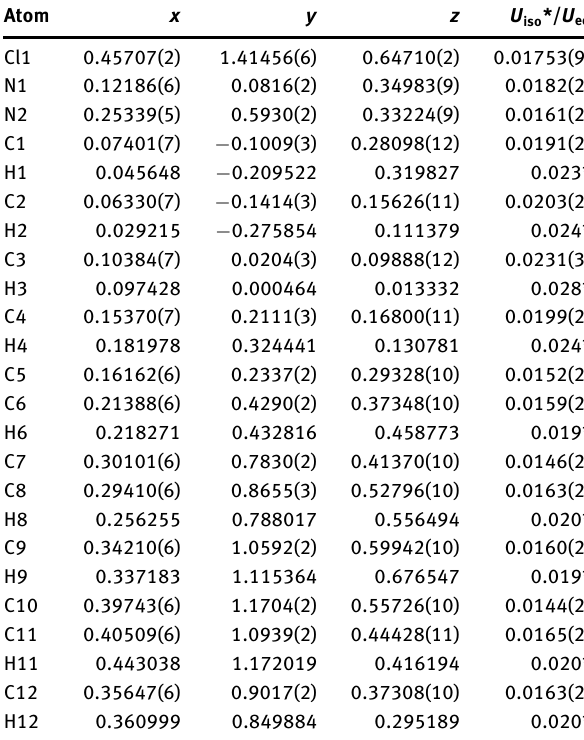
Table 2: Fractional atomic coordinates and isotropic or equivalent isotropic displacement parameters (Å 2